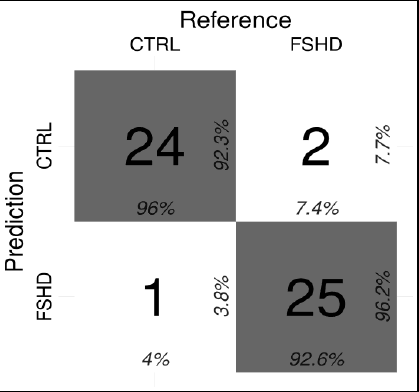
Figure 6. Confusion matrix indicating the correct and incorrect predictions performed by the ML classifier (Conditional Inference tree) for the FSHD vs. CTRL comparison. In particular, the methylation levels related to four CpG sites, namely DUX4 -